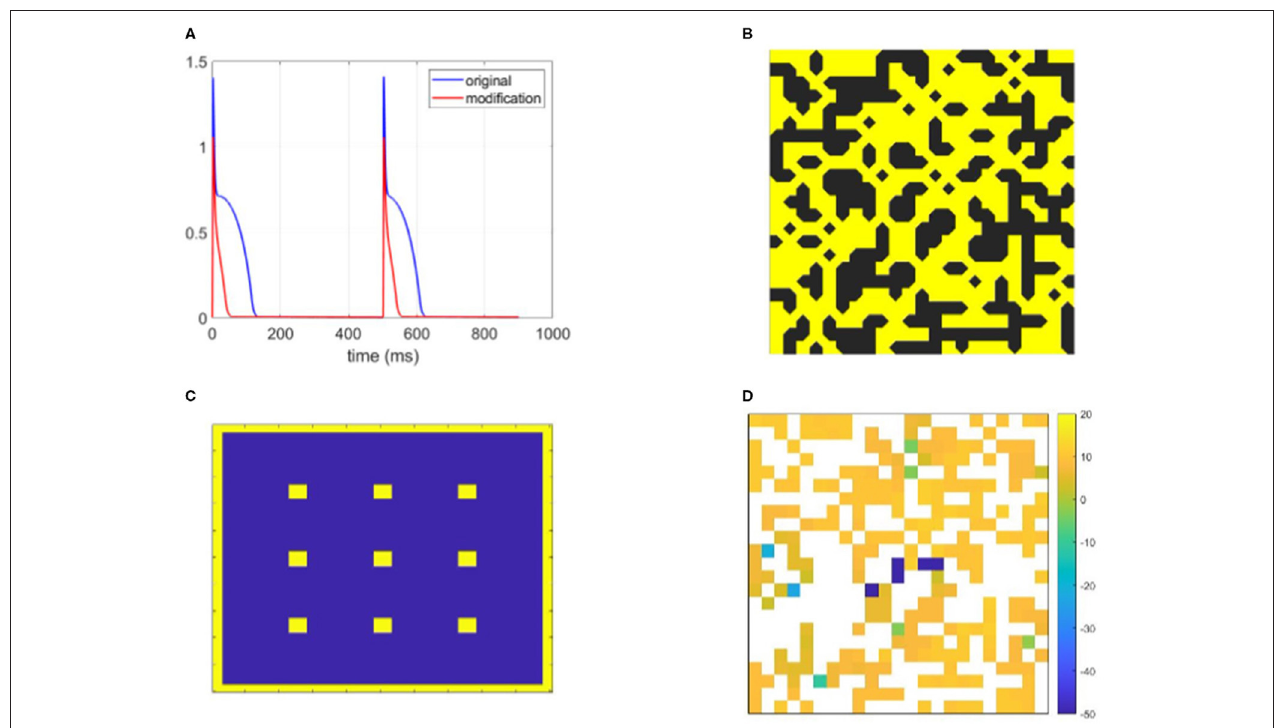
FIGURE 1 | Graphical demonstration of some of the methods used in this study. (A) The action potential (AP) of the Bueno-Orovio-Cherry-Fenton (BOCF) model modified to represent strongly fibrosis-afflicted tissue (parameters in Table 1 ), and the original BOCF model. Remodelled myocytes repolarise very rapidly with a triangular-shaped AP. (B) An example fibrotic structure, visualised to highlight the ‘diagonal’ connectivity inherent to placing nodes on element vertices. (C) The stimulus locations (yellow) used across separate simulations to generate wavefronts travelling in different directions and hence bolster identification of structures that produce re-entry. (D) Re-entry vulnerability index (RVI) values observed for the structure pictured in (B) , showing the identification (by significantly negative value) of locations that demonstrate selective conduction block.